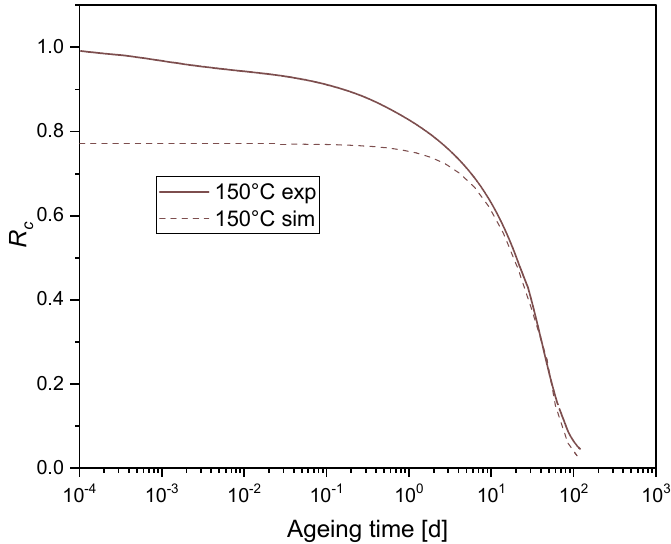
Figure 5. Normalized continuous stress relaxation for EPDM aged at 150 °C: Experiment and simulation with one degradative process and a relaxation time τ = 20